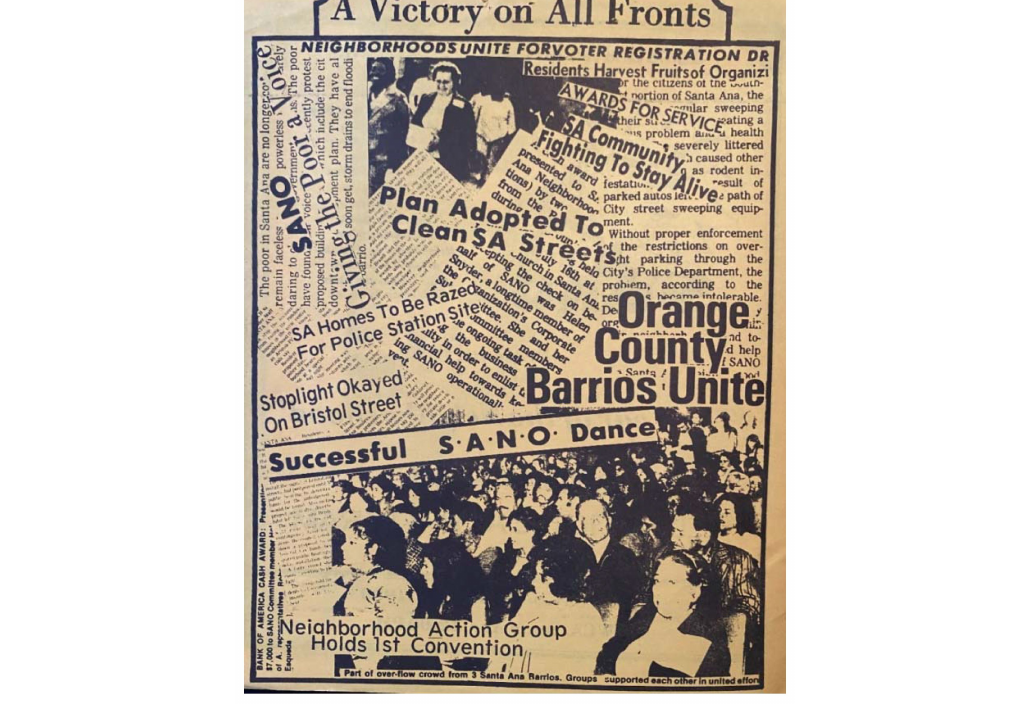
Figure 1. Santa Ana Neighborhoods Association (SANO) flyer, 6 September 1980. SANO drew support from broad sections of the community. Members of CU were active with SANO (Source: courtesy Susan Lu é